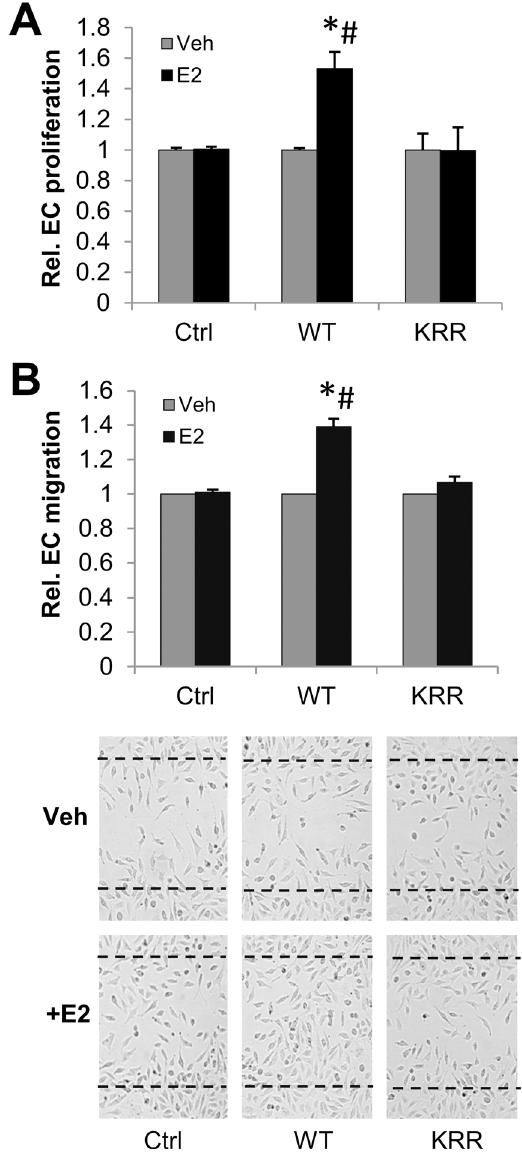
Fig 6. Rapid signaling through ER α is required for E2-dependent EC proliferation & migration. (A) Relative cell counts for stable Ctrl, WT or KRR hEC cell lines +/- 10nM E2, normalized to counts +Veh. (B) A “ scratch ” wound was made with a pipette tip on Control, WT or KRR hECs at near confluence, and the number of cells migrating into the scratch after 48 hours counted. Top: Quantitation of migration data. Bottom: representative images of cells after 48 hr migration. Dotted lines indicate the borders of the scratch at time 0. Data is normalized to +Veh for each cell line. * : different from WT+Veh, p. < 0.05, #: different from KRR+E2, p. <